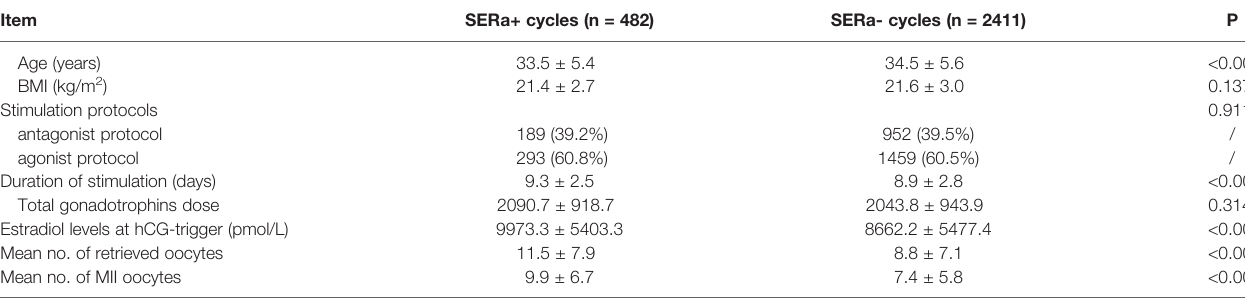
*SERa, aggregates of smooth endoplasmic